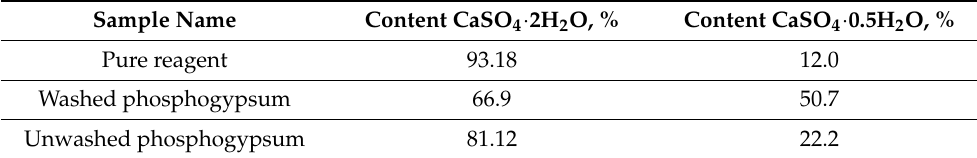
Table 3. The content of dehydrate and hemihydrate CaSO 4 in phosphogypsum.